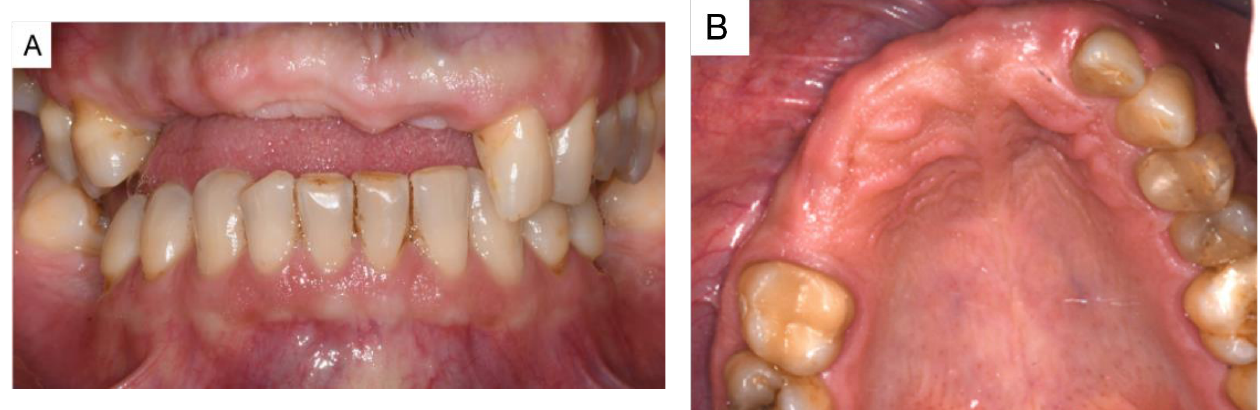
Figure 2. The pre-operative clinical situation of the second patient. Vestibular ( A ) and occlusal ( B ) point of view.